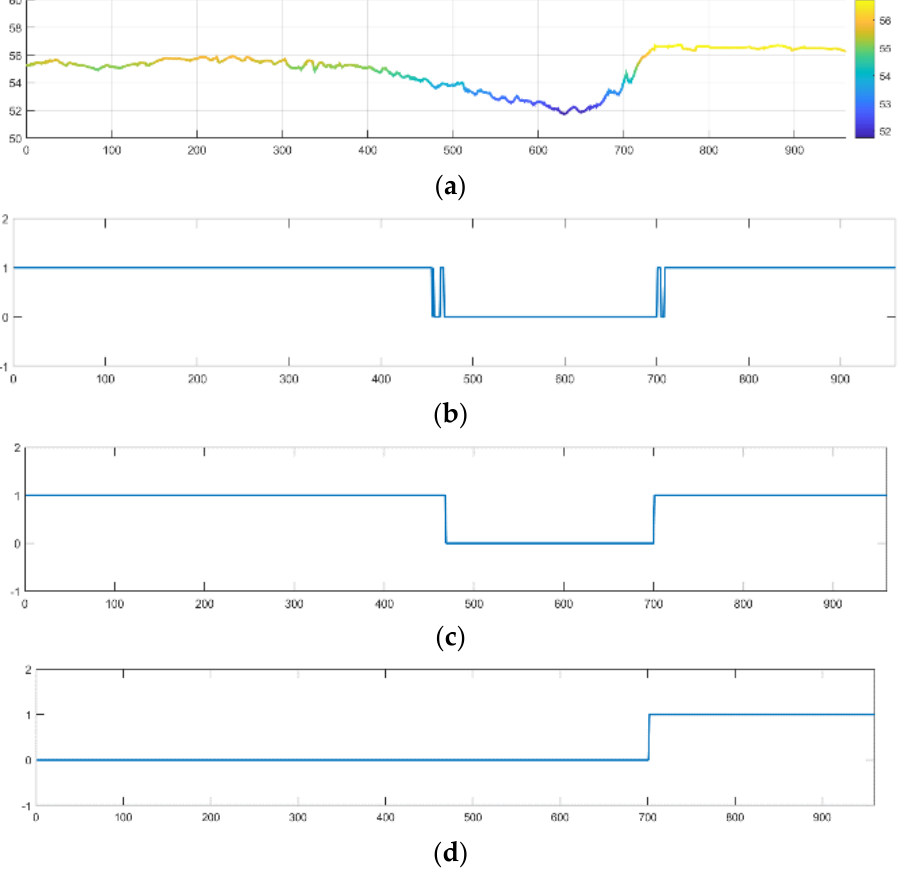
Figure 5. Top processing results of the image: ( a ) Projection results; ( b ) Shaped results; ( c ) Noise reduction results; ( d ) Selected results.